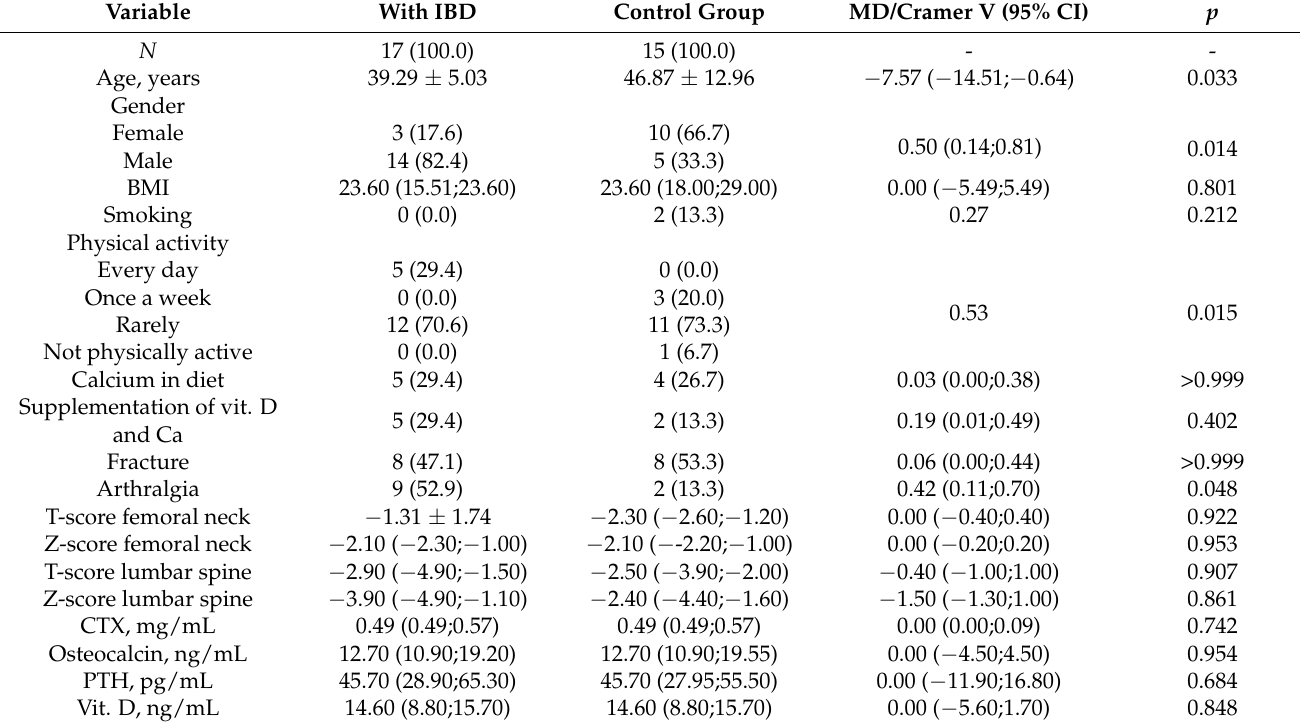
Table 4. Patients with osteoporosis in the IBD and the control